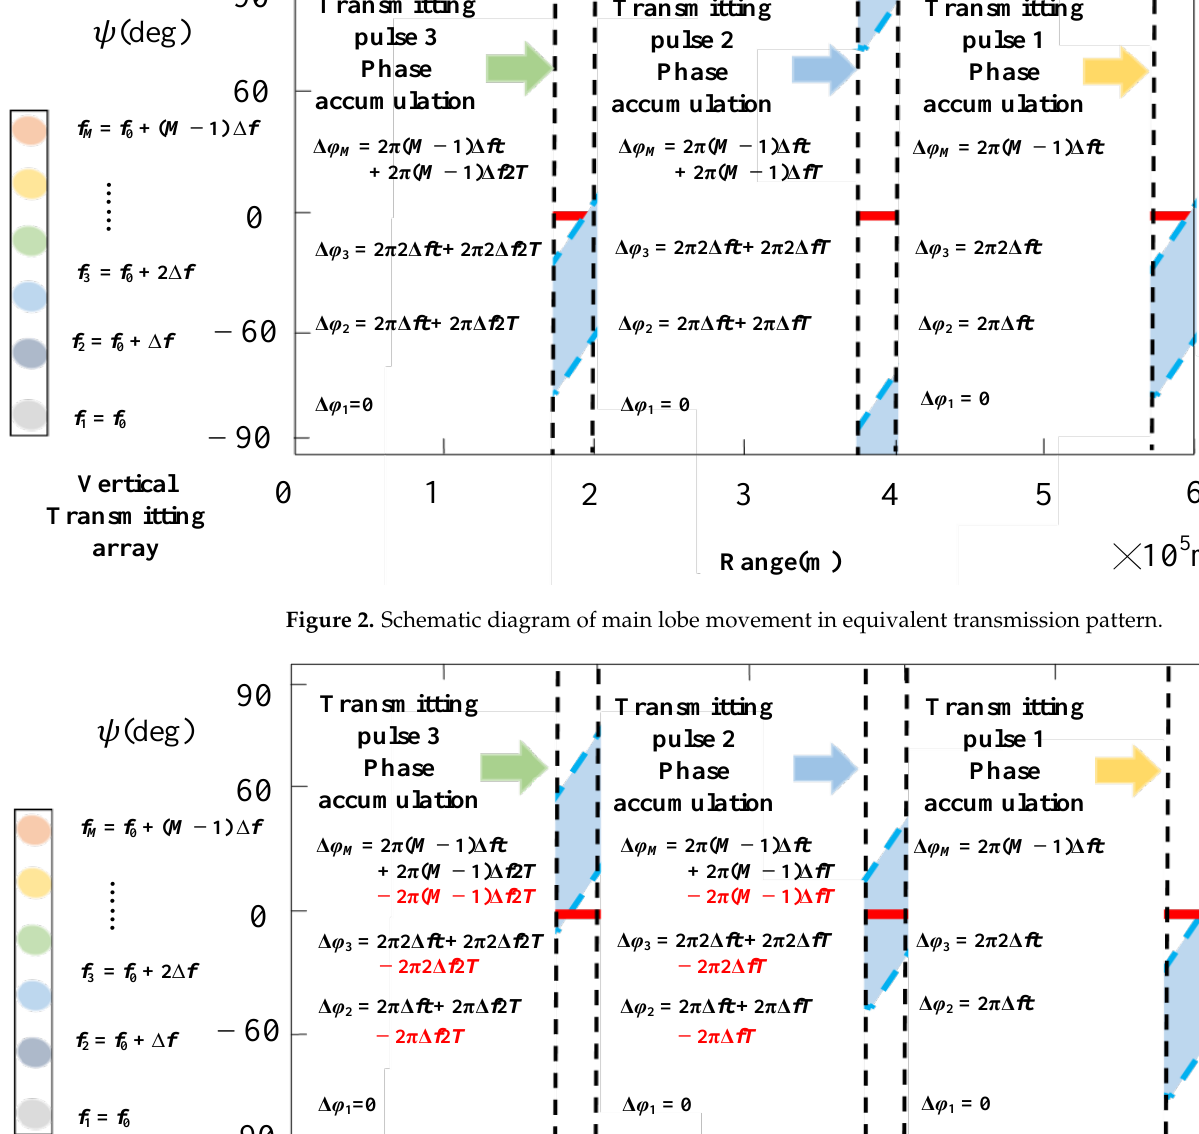
Figure 2. Schematic diagram of main lobe movement in equivalent transmission pattern.